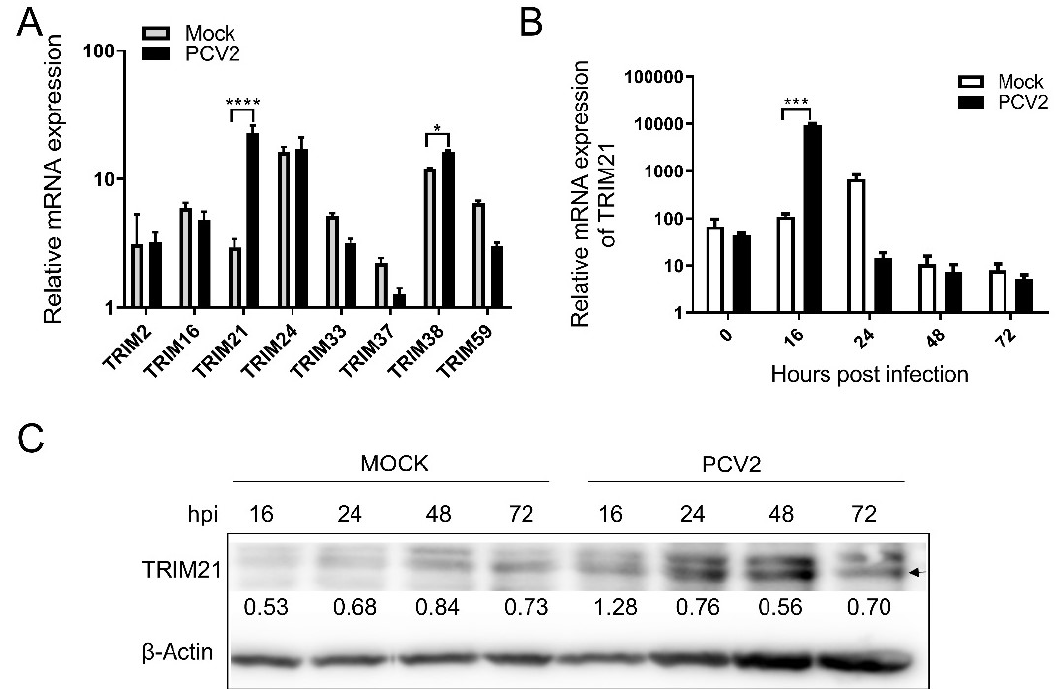
Figure 1. Expression of porcine TRIMs during PCV2 infection. ( A ) Expression of porcine TRIMs in PCV2-infected PK-15 cells. PK-15 cells were infected with PCV2 for 72 h, and total RNA and protein were collected and evaluated by qRT-PCR. The copies of TRIMs mRNA were normalized with GAPDH. ( B , C ) Expression of TRIM21 in PCV2-infected PK-15 cells. PK-15 cells were infected with PCV2, and total RNA and protein were collected at 0, 16, 24, 48, and 72 hpi, followed by qRT-PCR ( B ) and Western blot ( C ) analysis. The copies of TRIMs mRNA were normalized with GAPDH. For Western blot, TRIM21 rabbit polyclonal antibody (1:1000) and mouse anti- β -actin antibody (1:2000) were used as primary antibodies. HRP-labeled goat anti-rabbit IgG (H + L, 1:2000) and HRP-labeled goat anti-mouse IgG (H + L, 1:2000) were used as the secondary antibodies, respectively. The numbers indicate the relative protein levels of TRIM21 normalized by β -actin. Error bars indicate mean values of triplicates ± the standard deviations (SD). * p < 0.05; *** p < 0.001; **** p < 0.0001. Unprocessed original images can be found in Supplementary Figure S1.